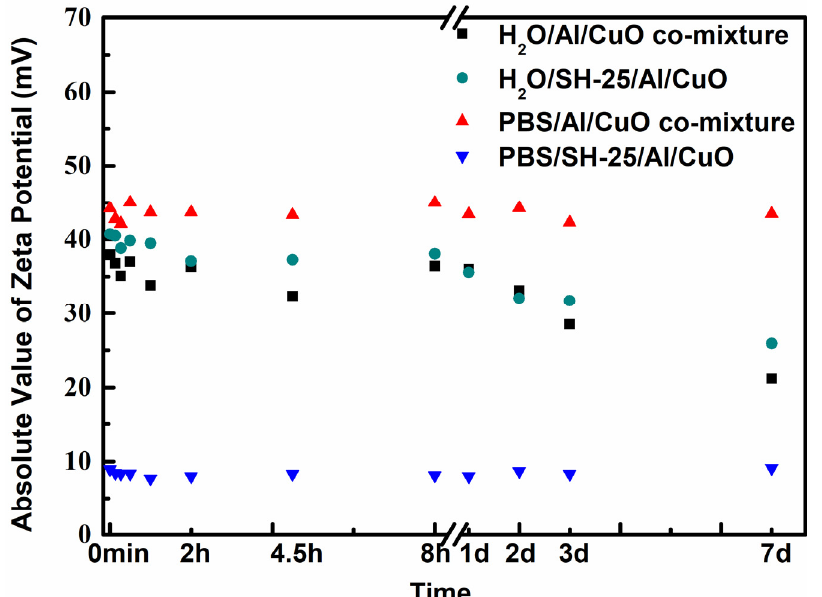
Figure 6. Impact of assembly time on the zeta potentials. PBS/Al/CuO comixture is represented by the red dots. PBS/SH-25/Al/CuO is represented by the blue dots. The black dots represent the H 2 O/Al/CuO comixture. The cyan dots represent H 2 O/SH-25/Al/CuO.